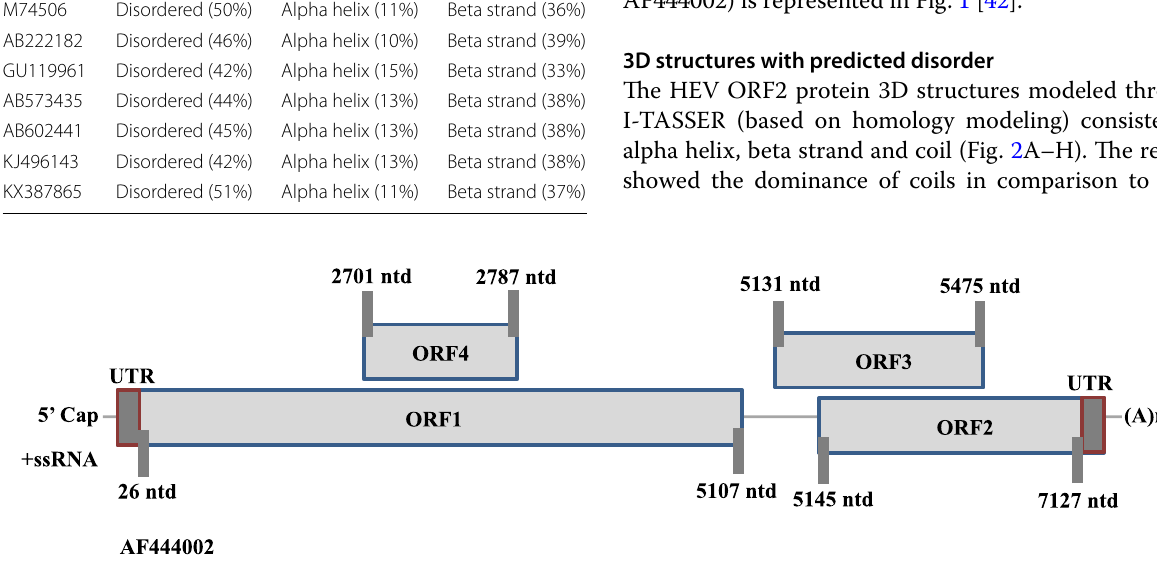
Fig. 1 Schematic representation of the genome of HEV. The genomic organization is organized into three open reading frames (ORFs), i.e., ORF1, ORF2, and ORF3. The nucleotide numbers are with reference to the strain Sar55 (GenBank Accession Number: